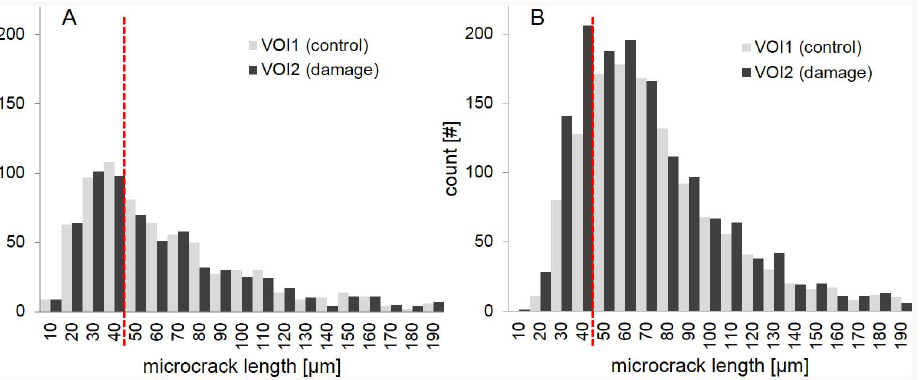
Figure 6. Distribution of microcracks length, in the control zone (VOI1) and the damage zone (VOI2) for all the fourteen specimens. (A) Only microcracks leading to the surface specimen are taken into account; (B) only microcracks fully embedded within the bone matrix are taken into account. In case of microcracks fully embedded within the bone matrix, there is a significant difference (p=0.01) in the number of microcracks having a length shorter than 40 m m between VOI1 and VOI2 in the damage zone.